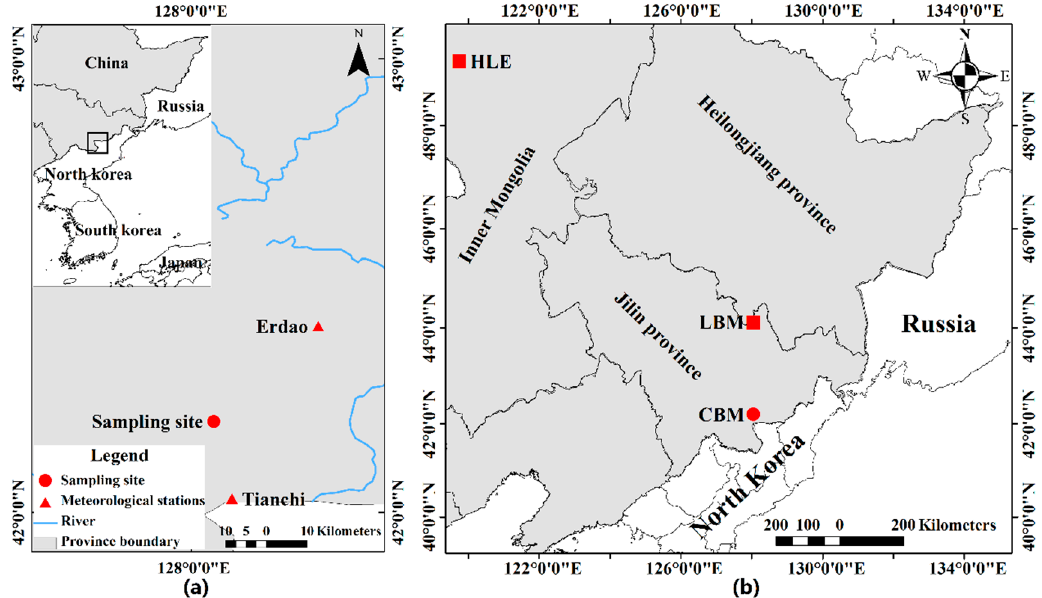
Figure 1. Map showing the sampling site of CBM (Changbai Mountain) and meteorological stations in Erdao and Tianchi ( a ), and the sampling site of CBM and other locations mentioned in text for comparison, including Laobai Mountain (LBM): April–July temperature [36] and Hailar (HLE): April–September temperature [27] ( b ).